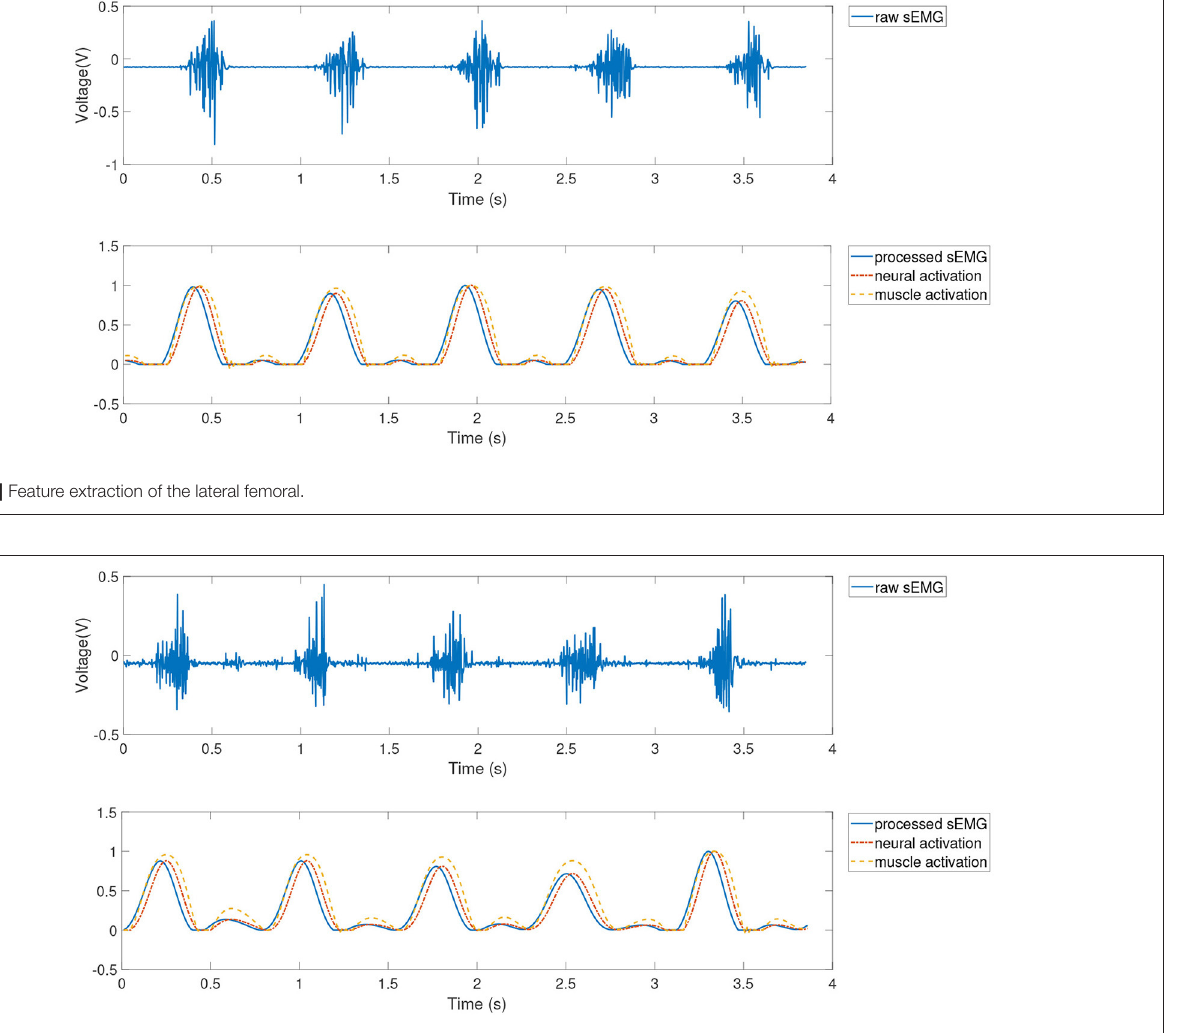
FIGURE 5 | Feature extraction of